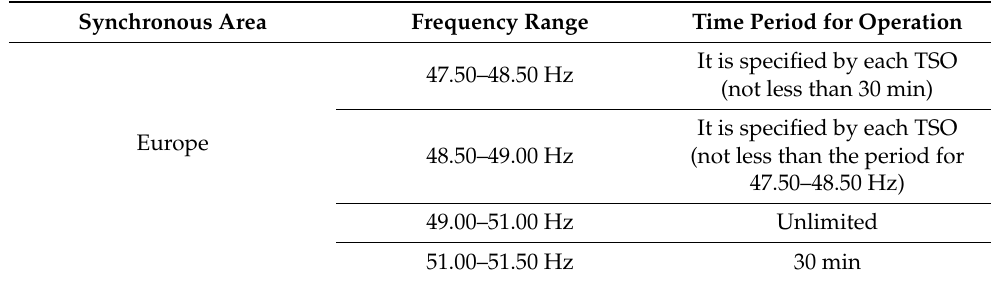
Table 5. Frequency range and operation time period for demand and generation facilities in Europe. Synchronous